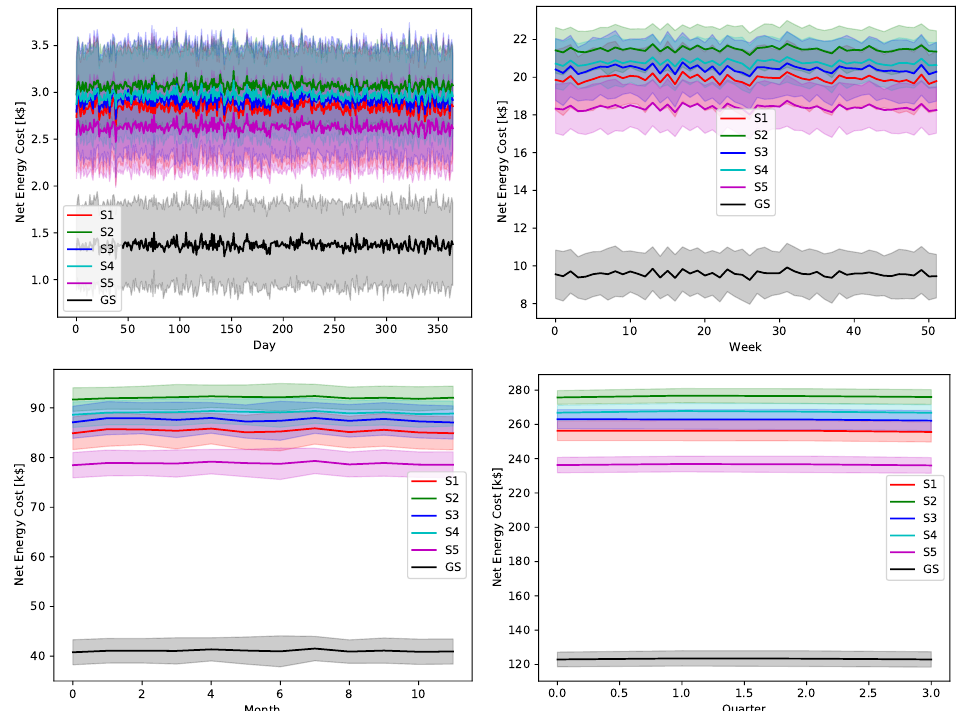
Figure 21. The total operation cost in terms of net energy purchase and sell revenue with a global certainty level U 75 .